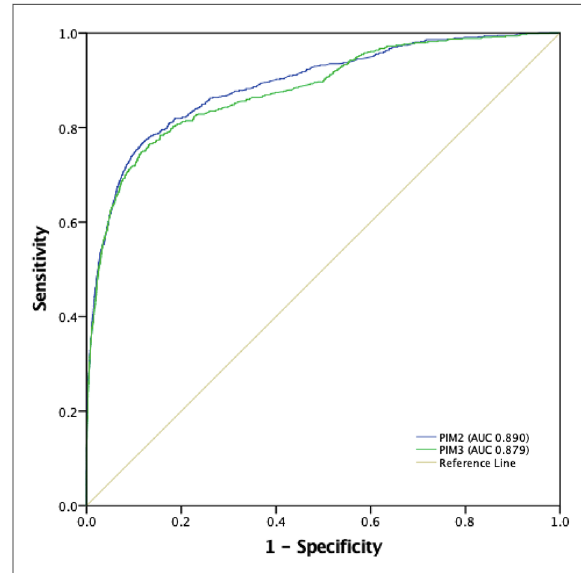
FIGURE 2 Receiver operating characteristic (ROC) curves for PIM3 and PIM2, and areas under the curve (AUROC). PIM2: 0.89 (95% CI 0.88-0.90); PIM3: 0.88 (95% CI 0.87-0.89) ( P =0.0018).